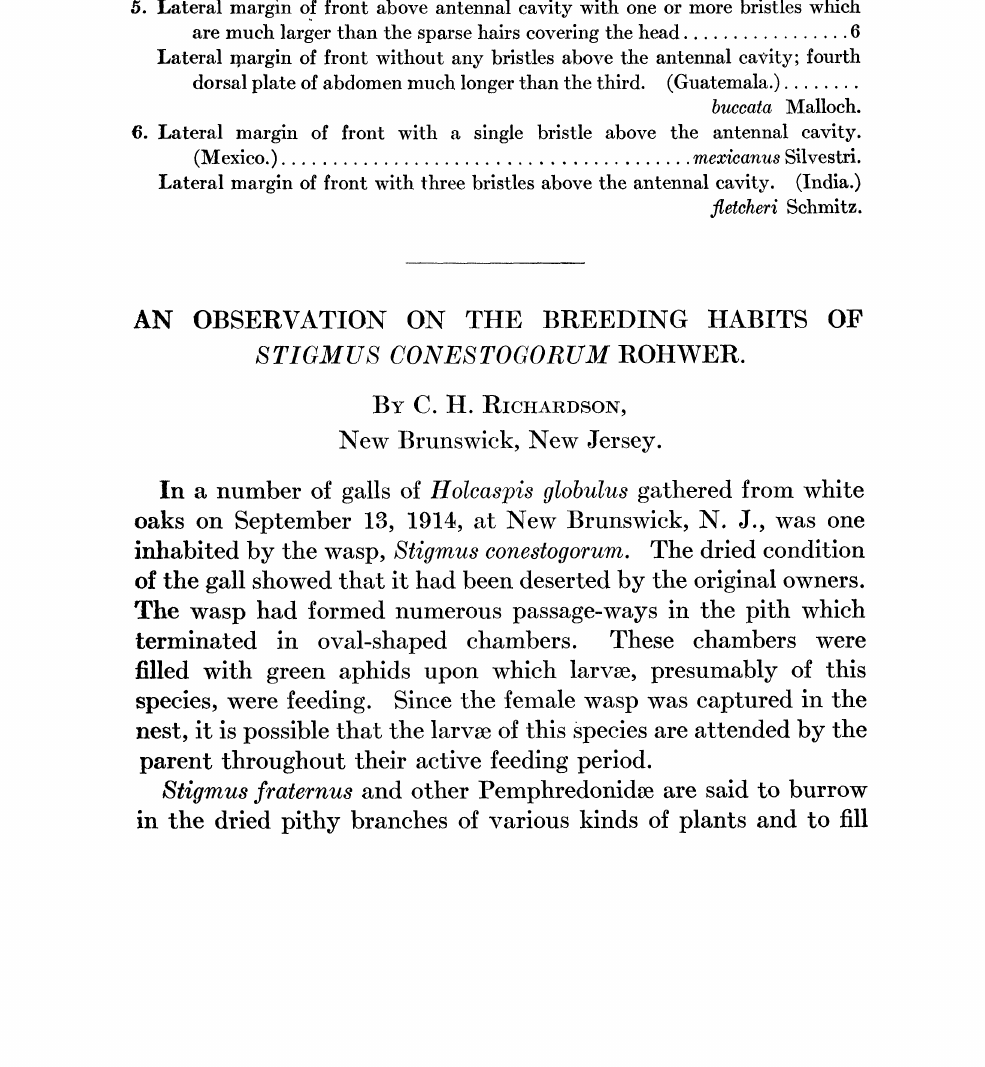
. Plates of abdominal segments uniformly pigmented, without transparent dots along their posterior margins 5 Front almost twice as broad behind as long 8 Front narrower in proportion to its length; three bristles on lateral margin of front above the antennal